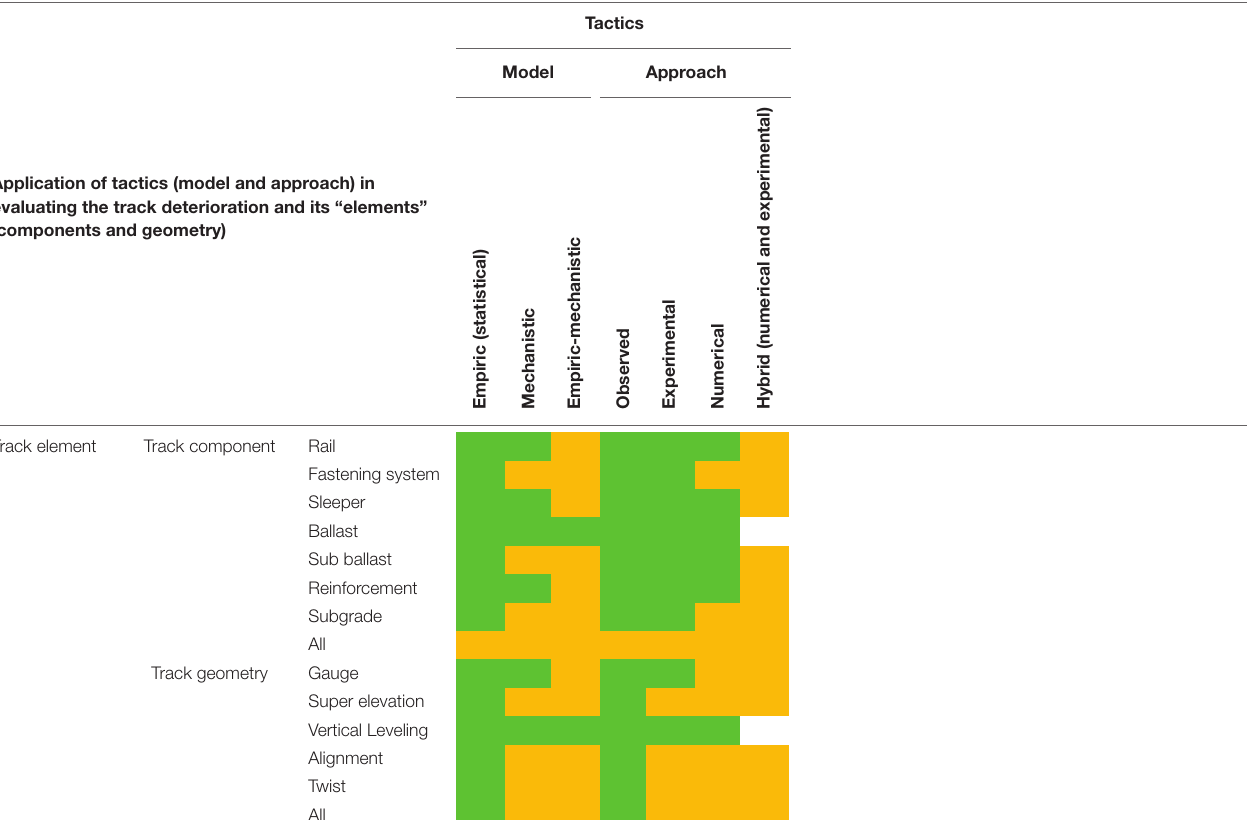
TABLE 6 | The established and potential tactics in evaluating track deterioration and its elements.